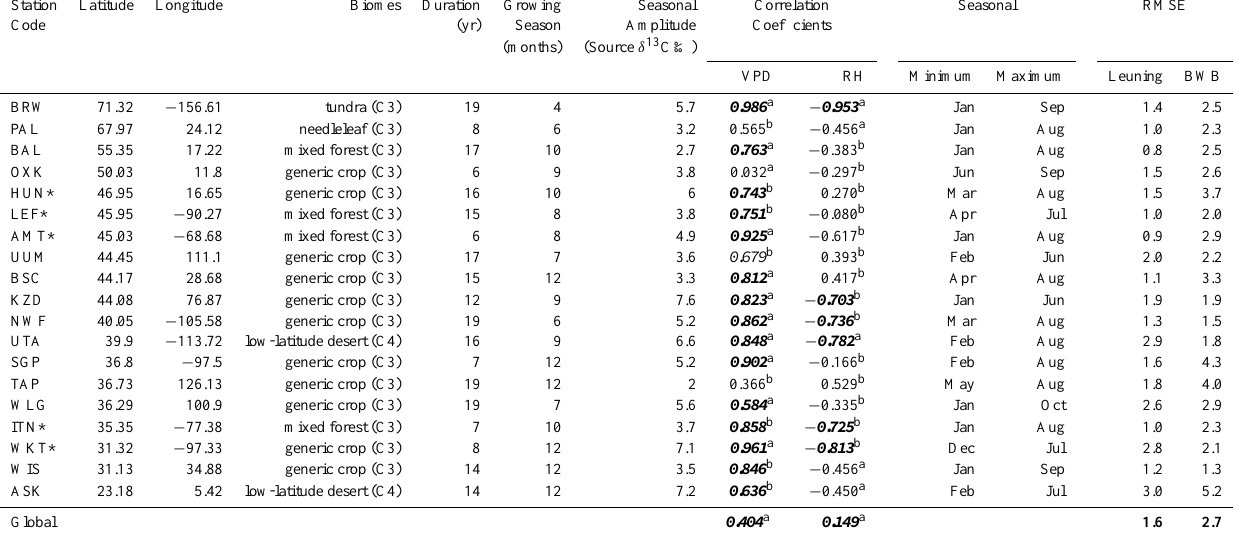
Table 1. Seasonal correlations between δ s and metrics of atmospheric water vapor for terrestrial sites from the NOAA/ESRL network included in this analysis. For each site the corresponding station code from the NOAA/ESRL flask network and the biome according to SiB3 are reported in addition to the duration and growing season length of the dataset included in the analysis. Correlation coefficients ( r ) are reported between seasonal distributions of δ s and vapor pressure deficit (VPD) and relatively humidity (RH), respectively (see Fig. 2). The sign of the correlation coefficient indicates the sign of the relationship. Significant correlation coefficients ( p < . 05) appear in italics and highly significant correlation coefficients ( p < . 01) appear in bold italics. Root mean squared error (RMSE) are reported for growth season predictions of δ s from the Leuning and BWB stomatal conductance models compared with δ s values inferred from the atmosphere. Mean RMSE values across all sites are also reported.